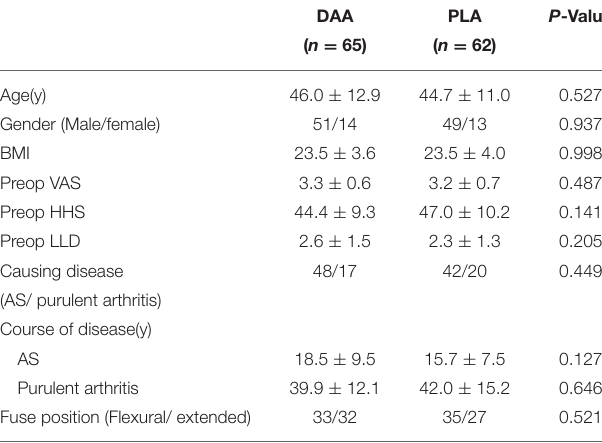
TABLE 1 | Demographics and baseline characteristics of included